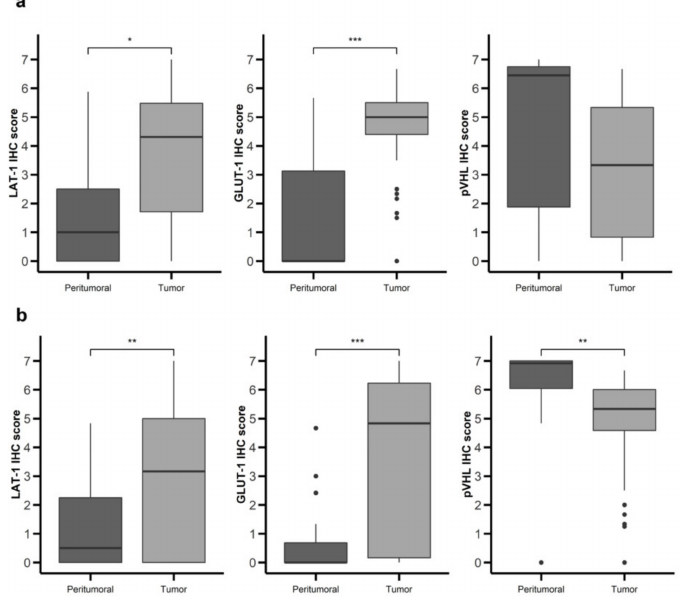
Figure 2. Nutrient transport markers are di ff erentially expressed in GEP-NETs compared to normal adjacent tissue. LAT-1, GLUT-1, and pVHL were measured by immunohistochemistry (IHC) in a set of TMAs ( n = 164) from GEP-NETs, including primary and metastatic tissue. Values are represented as boxplot of IHC scores in tumor tissue and in normal peritumoral tissue. ( a ) Comparison in gastroenteric NETs. ( b ) Comparison in pancreatic NETs. Boxplots visualize five statistics (the median, first quartile, third quartile, and two whiskers). The upper and lower hinges correspond to the third (75th percentile) and first (25th percentile) quartiles. The upper whisker extends from the hinge to the largest value no further than 1.5 fold the interquartile range (IQR) of the hinge. The lower whisker extends from the hinge to the smallest value at most 1.5 fold the IQR of the hinge. Asterisks indicate significant di ff erences between tumor and peritumoral tissues (* p < 0.05, ** p < 0.01, *** p <